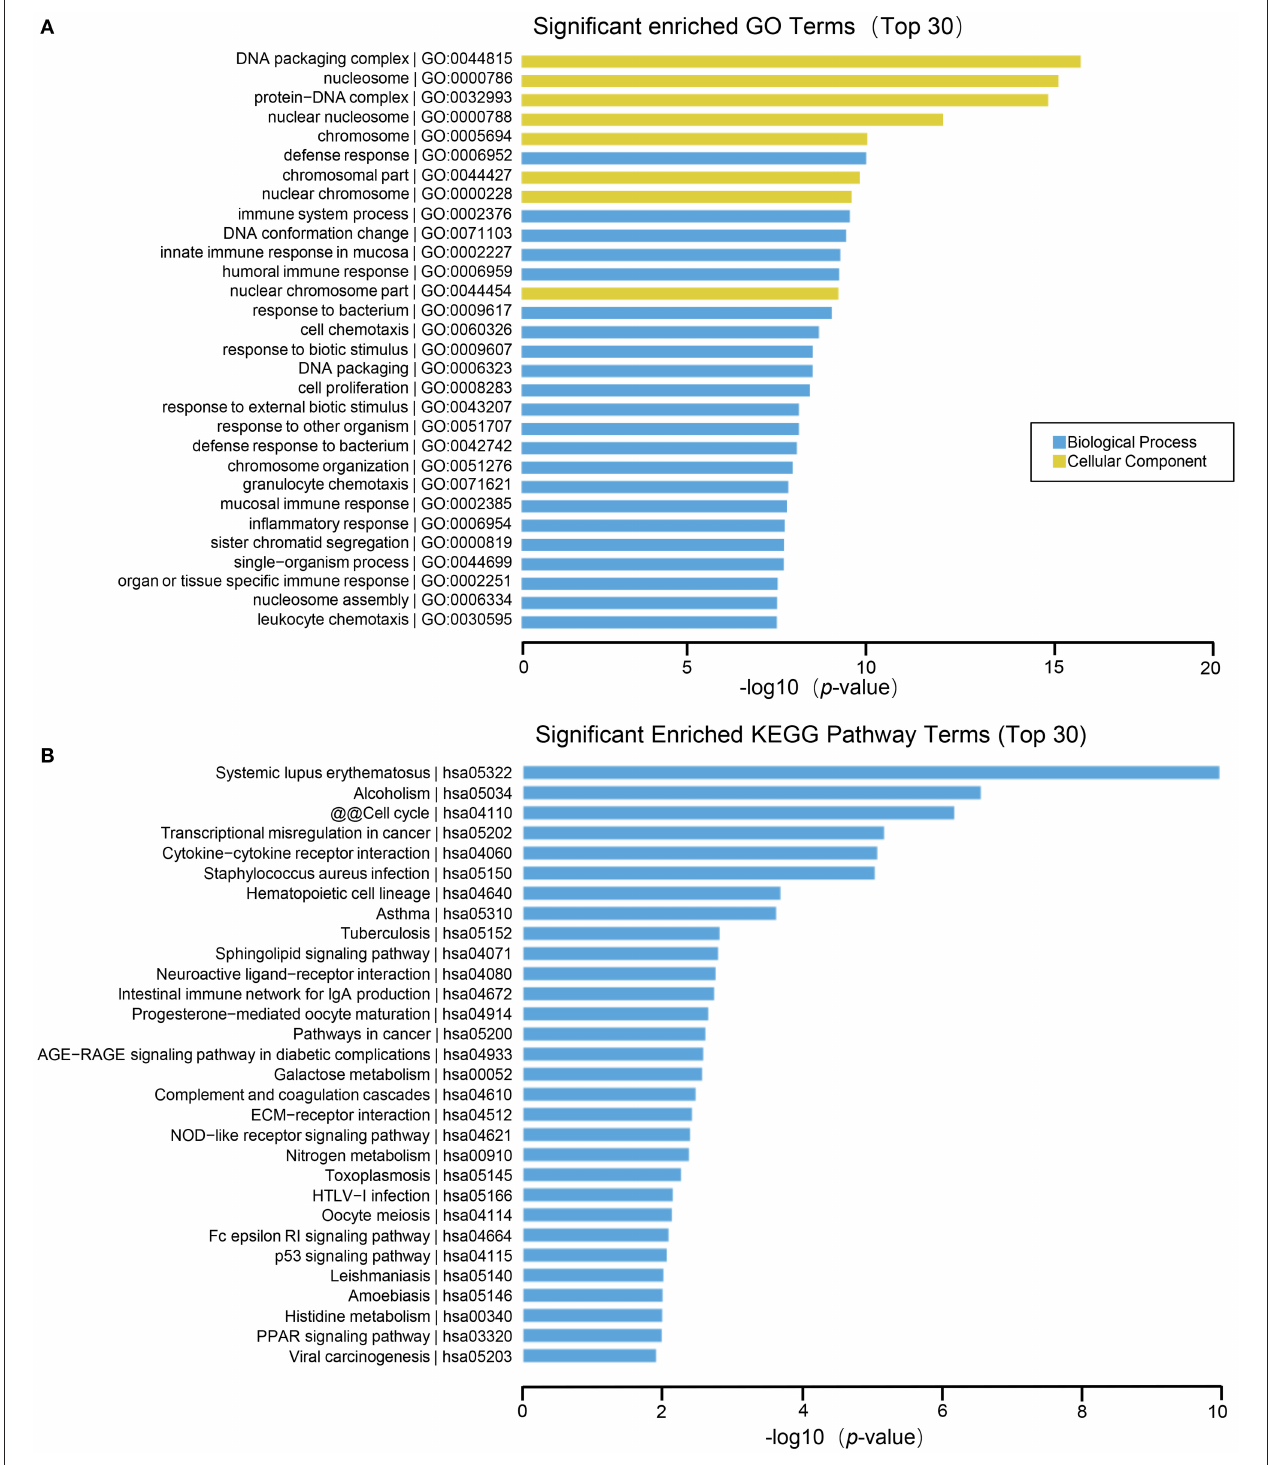
FIGURE 4 | GO and KEGG pathway analysis on the results of lncRNAs. (A) Gene ontology analysis. Top 30 GO terms for the difference in lncRNA between HT group and non-HT group. (B) KEGG pathway analysis. Top 30 pathways for the difference in lncRNA between HT group and non-HT group.